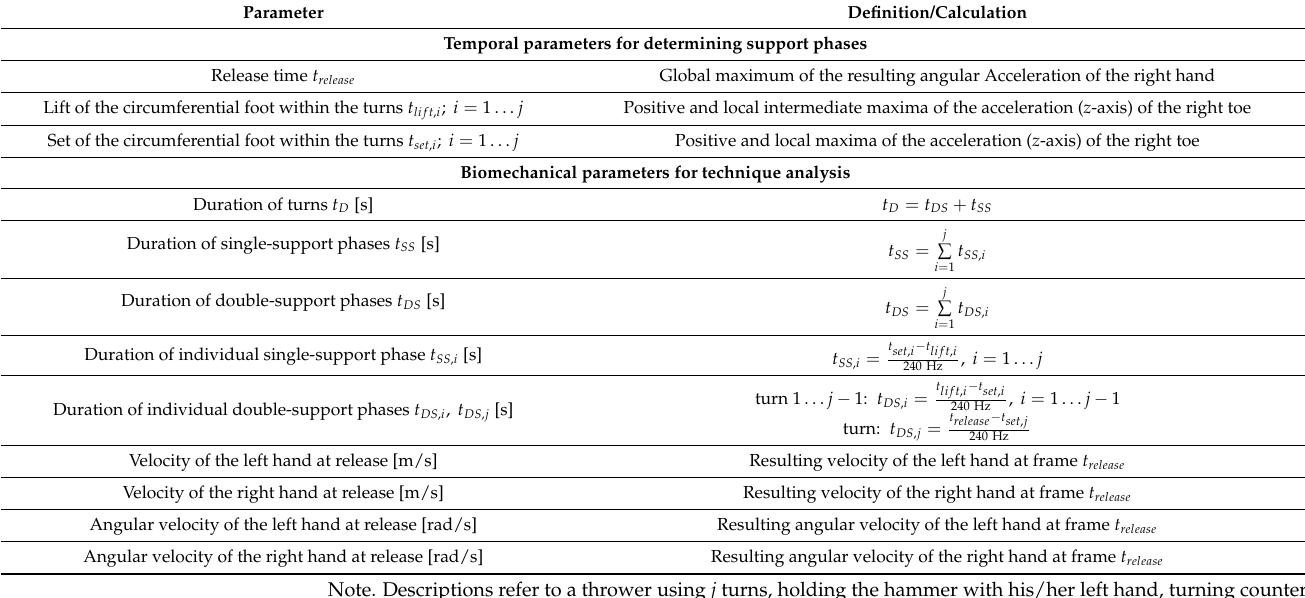
Figure 4. IMU placement under the Velcro fastener of the shoe. Table 2. List and definitions of parameters used for determination of double- and single-support phases and for